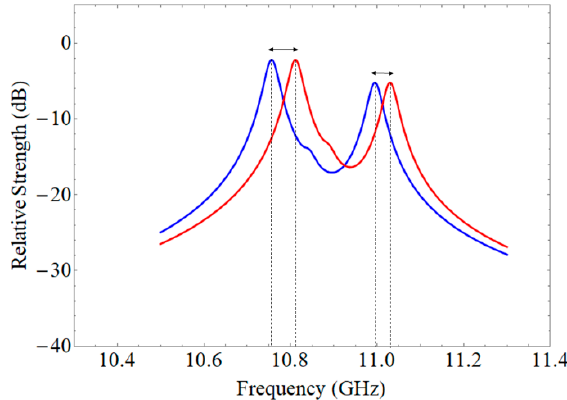
Figure 7. Example of a BGS tailored to have two acoustic mode interactions of similar strength. The responses of the modes to changes in T or ε differ. This illustration may represent a typical fiber whose temperature or applied strain has been increased in going from the blue to the red curve.